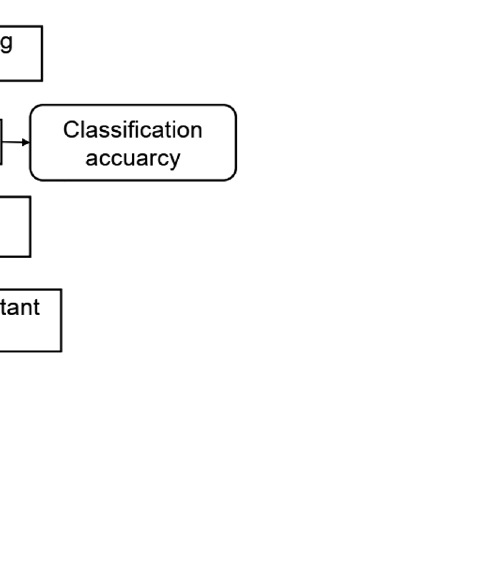
Figure 1. The RF-RFE